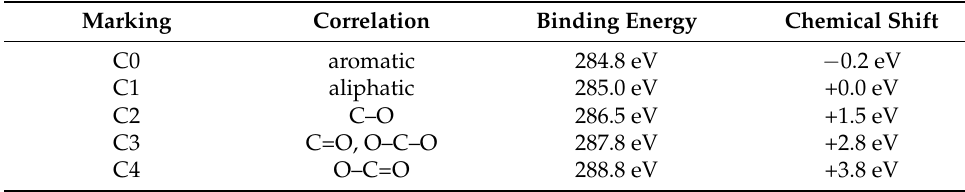
Table 1. XPS binding energies according to [41].